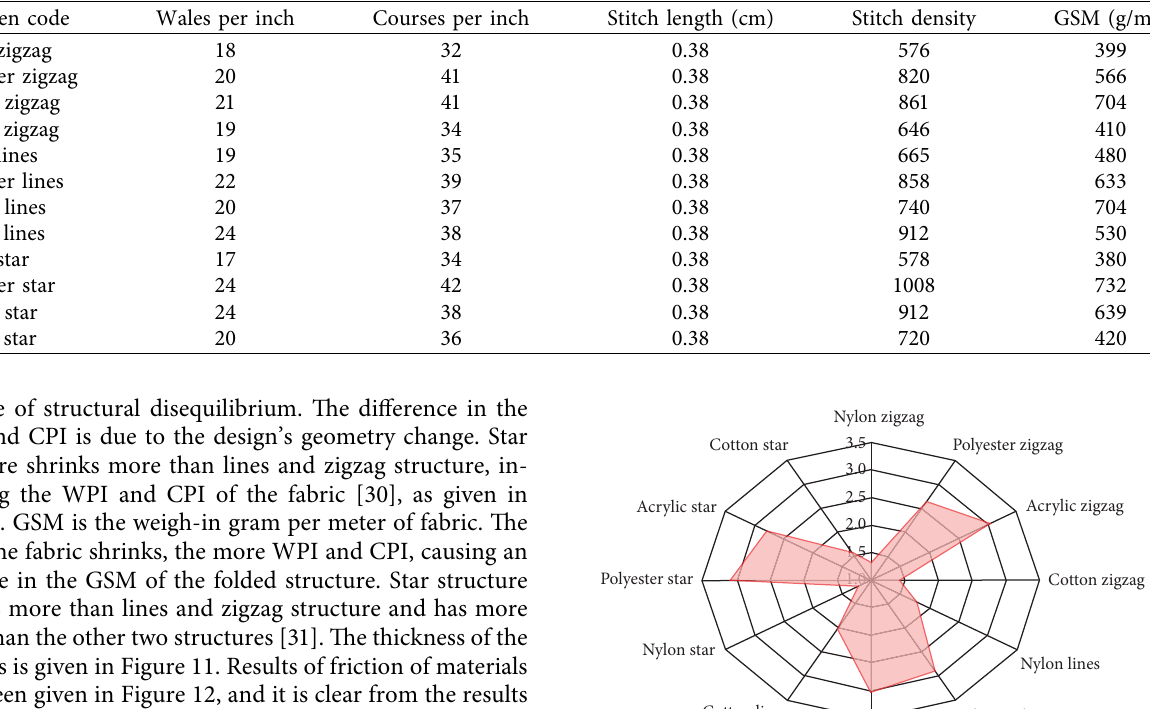
Table 6: Physical parameters of samples.